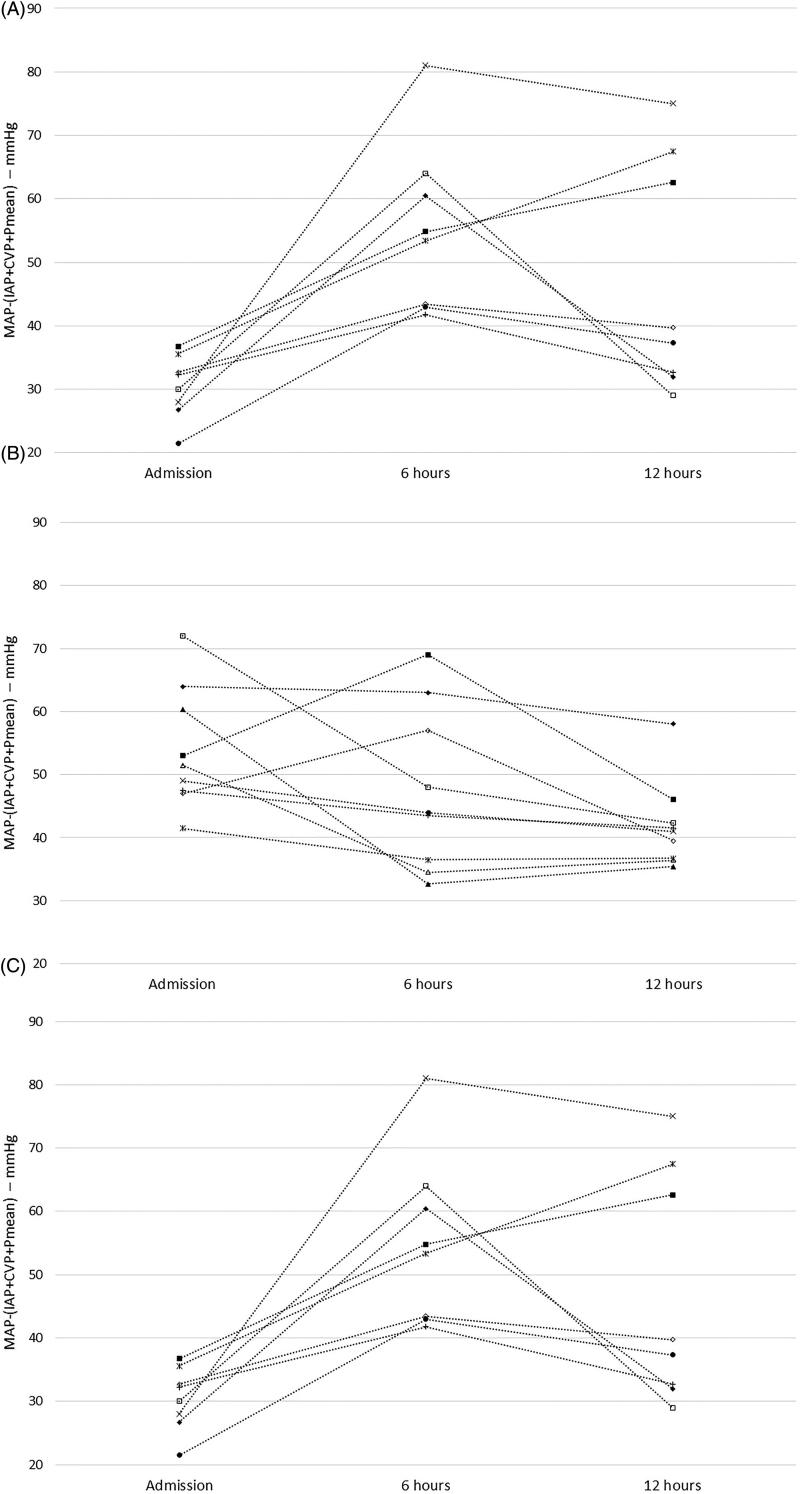
The patients' data with (A) below 40.7 mmHg of MAP−(IAP + CVP + Pmean) and above it (B) with or (C) without AKI in the first 12 h.